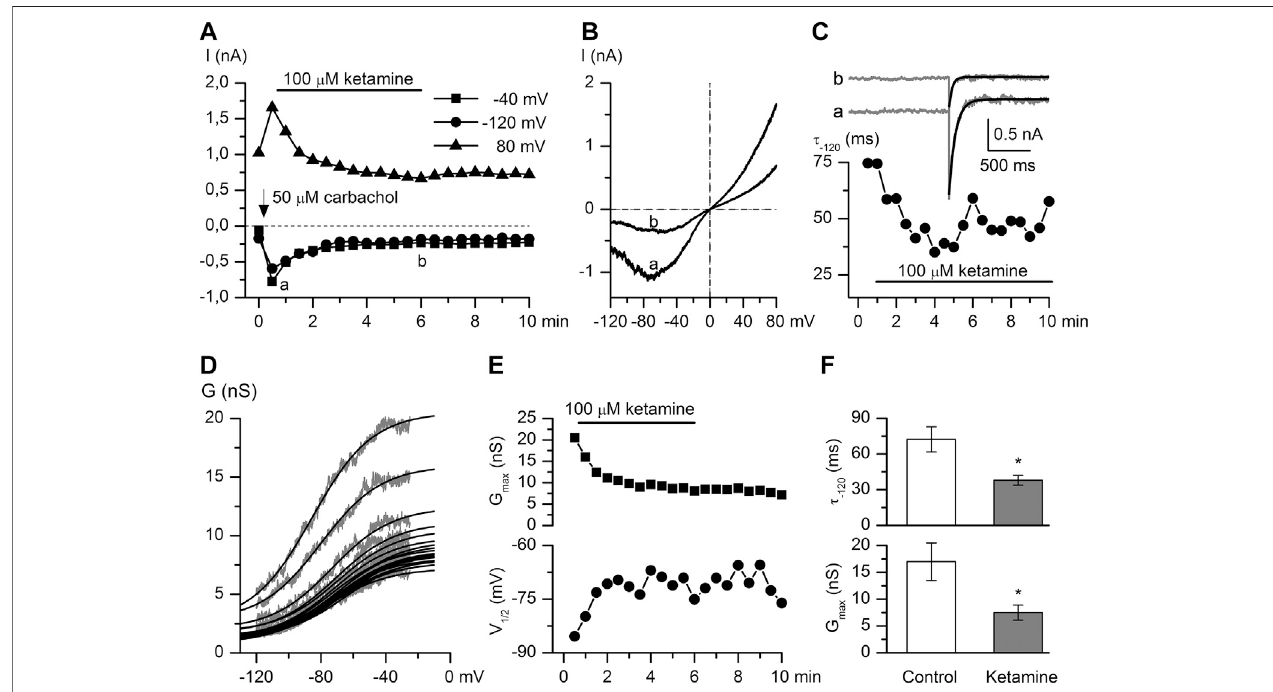
FIGURE 3 | Ketamine strongly inhibits CCh-induced mI CAT . (A) Time course of mI CAT evoked by CCh (50 μ M) and inhibited by ketamine (100 μ M) application at threedifferenttestpotentials,asindicated. (B) Representativesteady-stateI – VrelationshipsofmI CAT atmaximumresponsetoCChandduringmaximalcurrentinhibition by ketamine (i.e. at time points aand b indicated in panel A). (C) mI CAT voltage-dependentdeactivation kineticsduring voltage step from − 40 to − 120 mV fi tted bysingle exponentialfunction(superimposedsmoothblacklines)atthesametimepointsmarkedaandbinpanel A . (D) Cationconductanceactivationcurveswere fi ttedby the Boltzmannequationshown bythe superimposed smooth black lines. (E) Ketamine not only markedly reducedthe maximal conductance (G max ) (top panel), but also shifted the potential of half-maximal activation (V 1/2 ) positively (bottom panel). (F) Mean deactivation time constant of mI CAT (top) and Gmax (bottom) in control and at steady-state inhibition by ketamine.